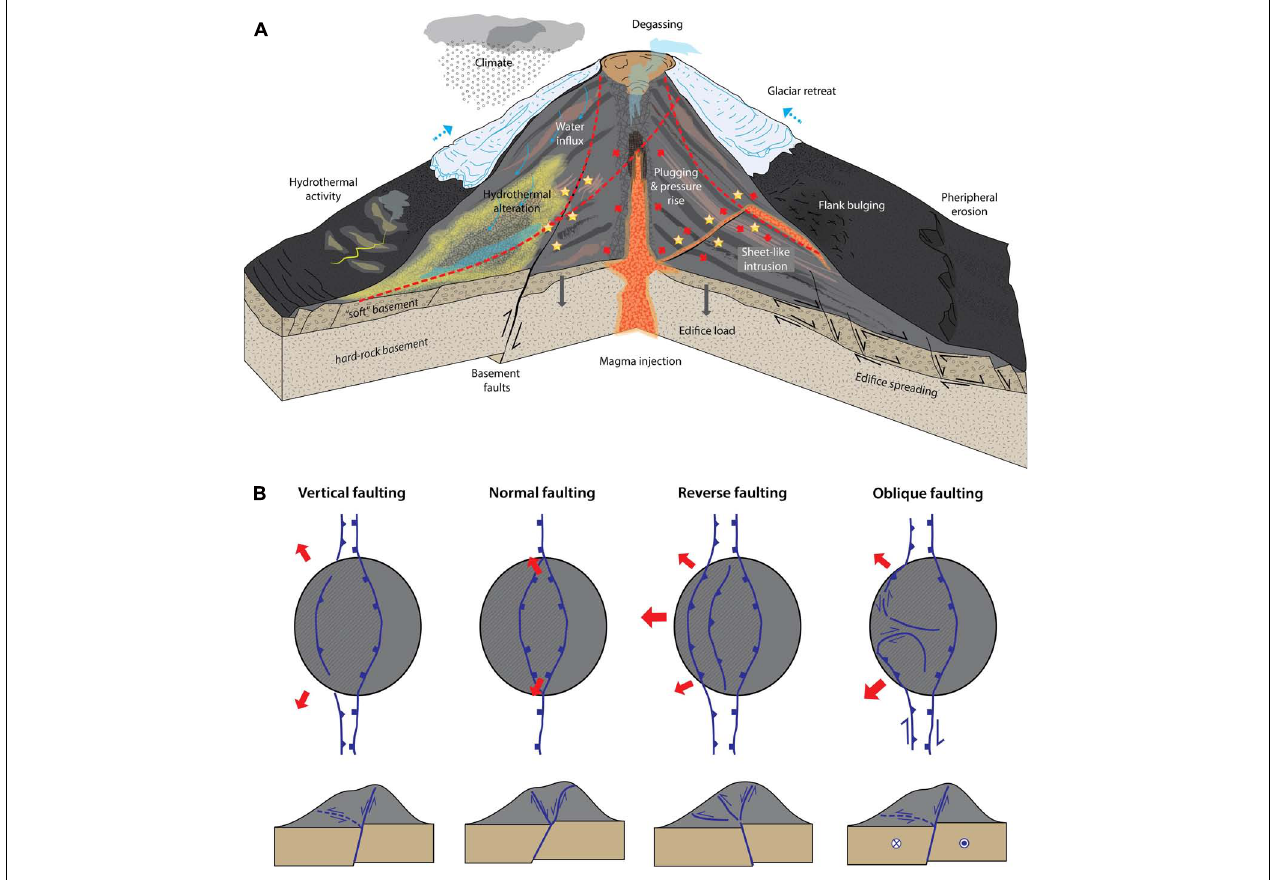
FIGURE 6 | Instability of mafic polygenetic volcanoes. (A) Cartoon (not to scale) illustrating the different internal and external sources of instability. Potential slide planes are red dashed lines, while seismicity and deformation are indicated by yellow stars and red arrows, respectively; (B) Styles of basement faulting and corresponding styles of collapse at volcano edifices (modified from Mathieu et al.,